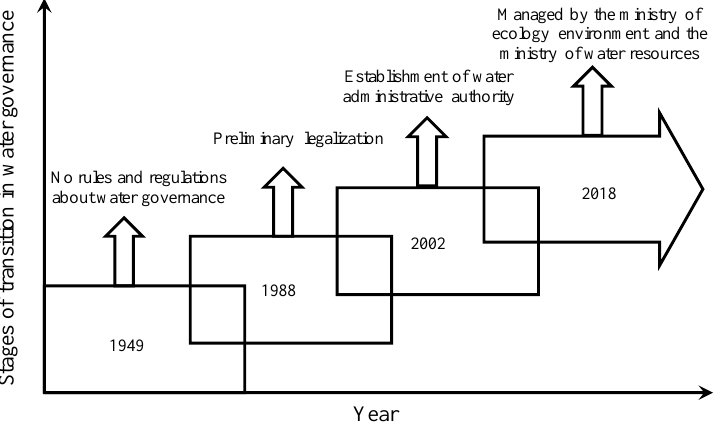
Figure 1. Stages of transition in water governance of China.